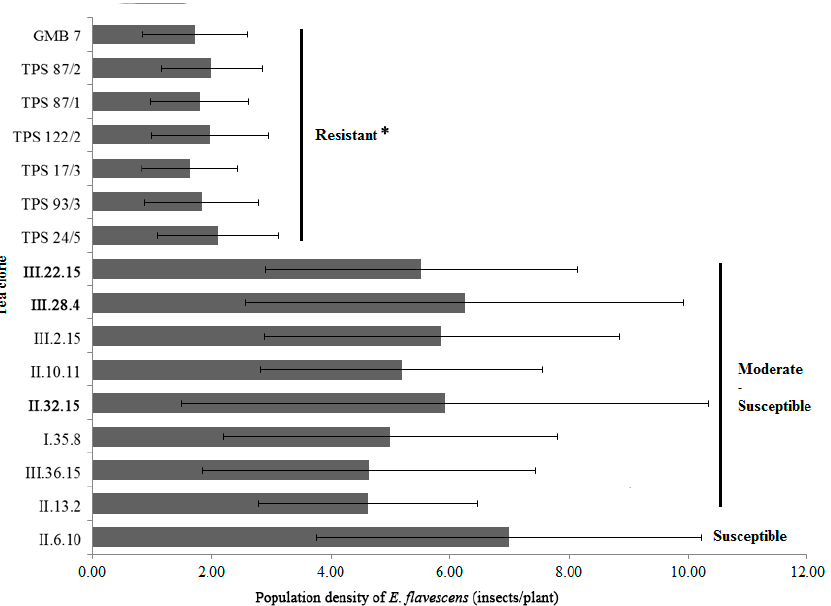
Figure 2. Population density of the leafhopper E. flavescens on plants of different tea clones. Data represent mean ± SD. The asterisk indicates significant differences between groups ( p < 0.05).